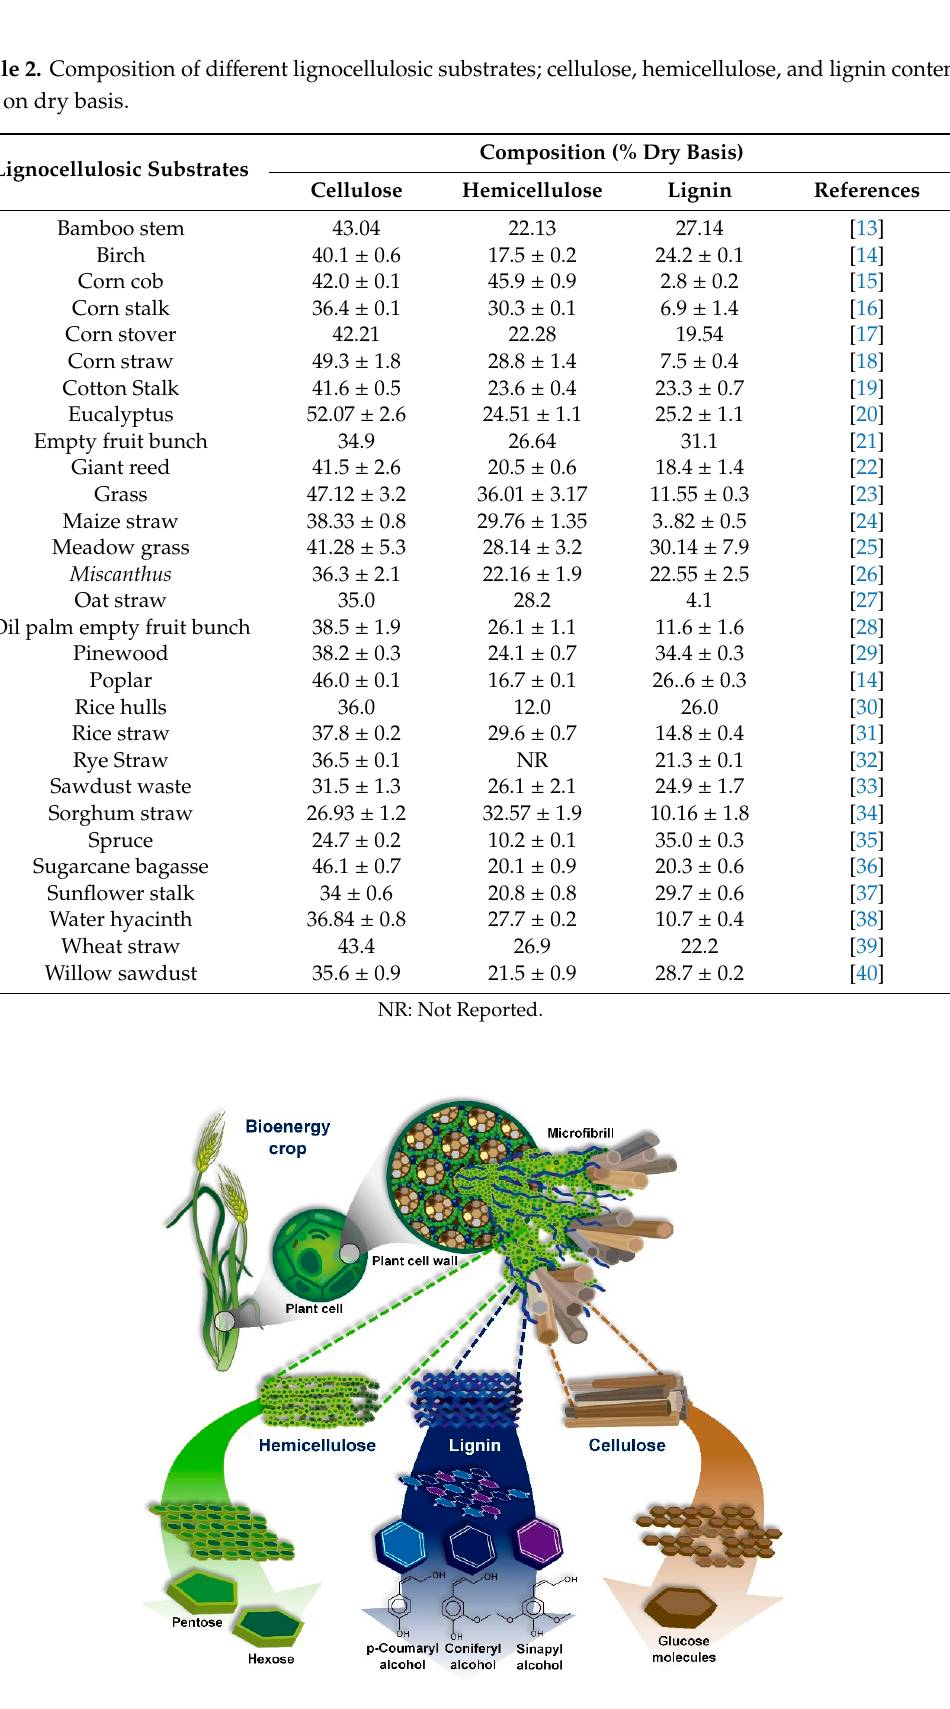
Figure 2. Structure of lignocellulosic biomass and its biopolymers; cellulose, hemicellulose, and